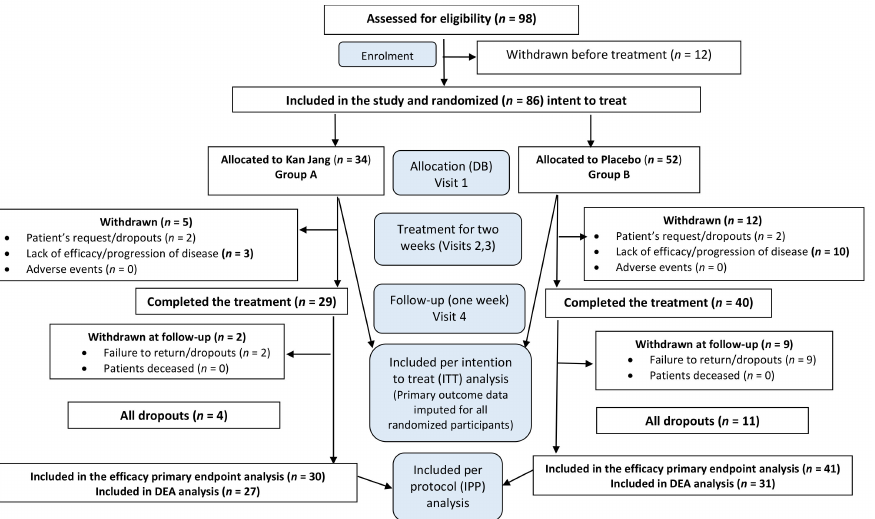
Figure 1. Schematic diagram of the trial. For details on the disposition of patients, see Supplementary File